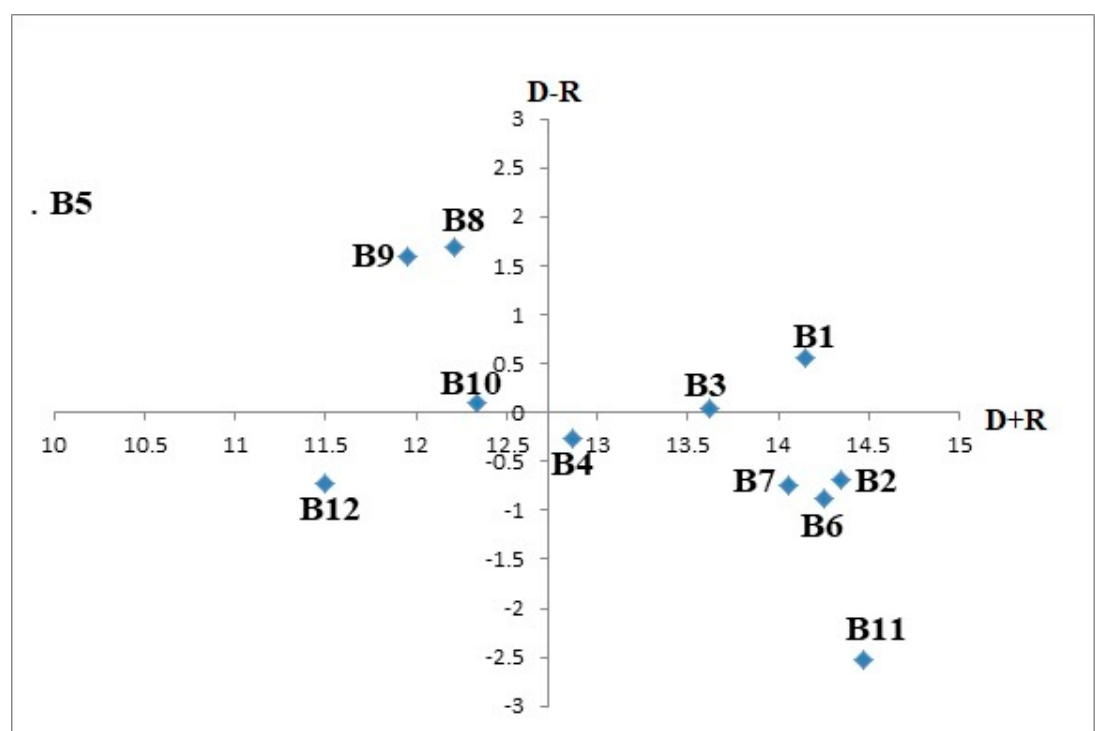
Figure 2. Cause-effect diagram.